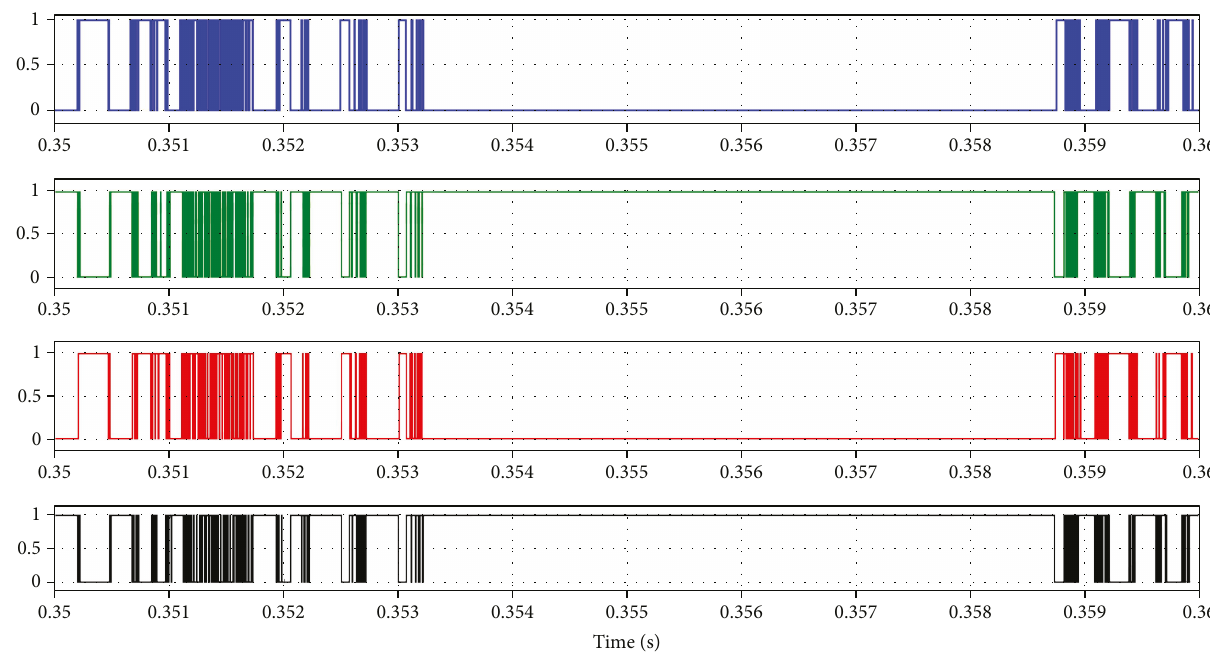
Figure 10: Switchings belonging to a phase when the STATCOM device with a PI controller is enabled.